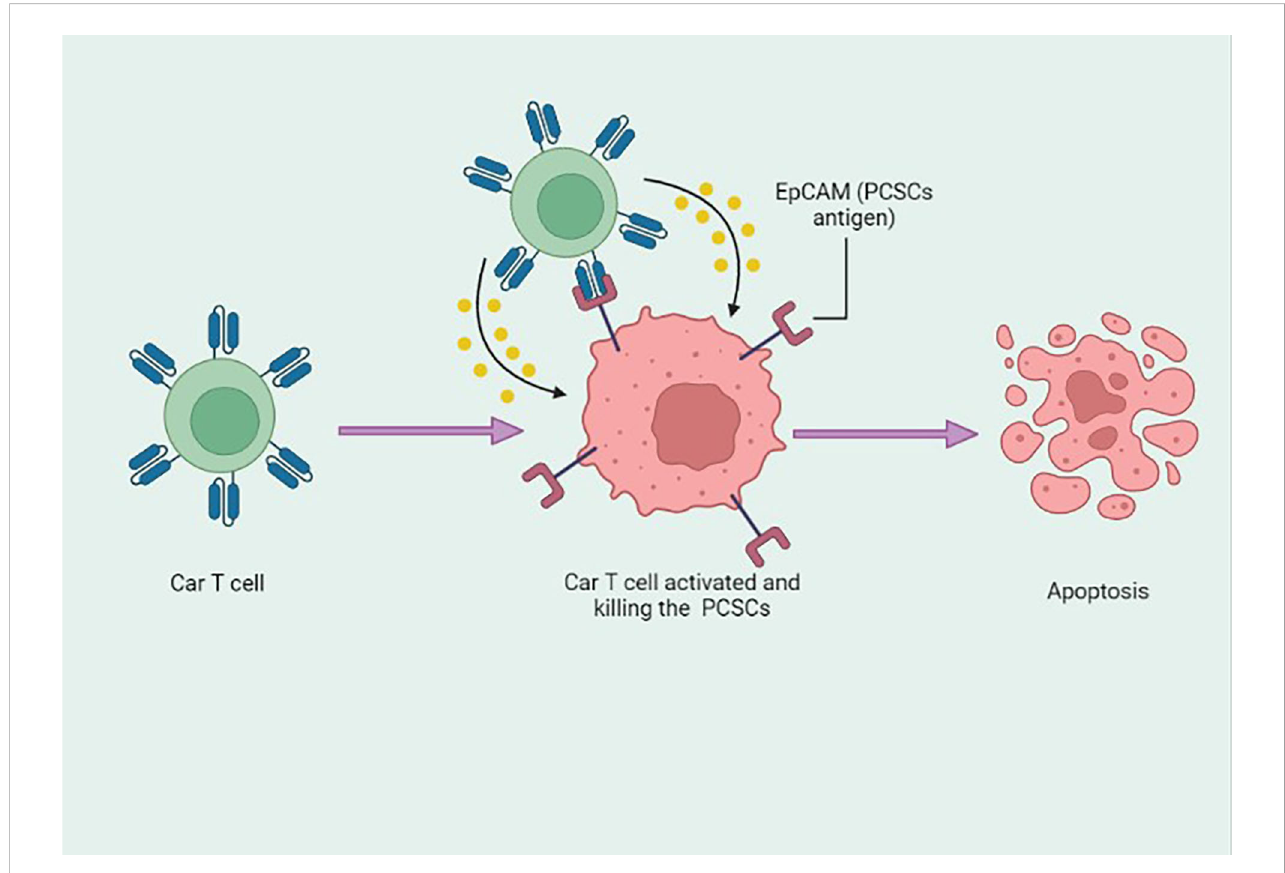
FIGURE 4 Epithelial cell adhesion molecule (EpCAM) antigen-based engineered CAR-T cells speci fi cally targeting the prostate cancer stem cells (PCSCs) and inducing apoptosis. This fi gure was created with